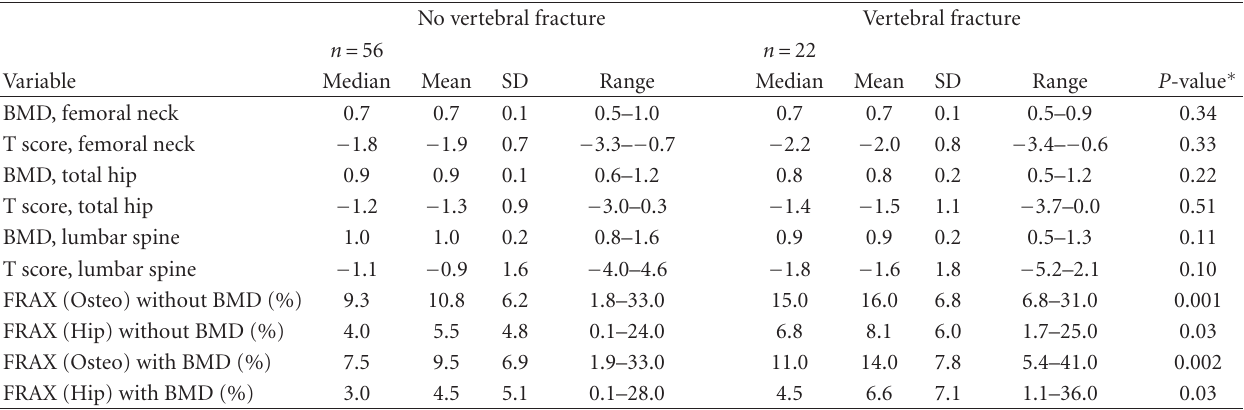
Table 2: BMD and FRAX stratified by presence of vertebral fracture.